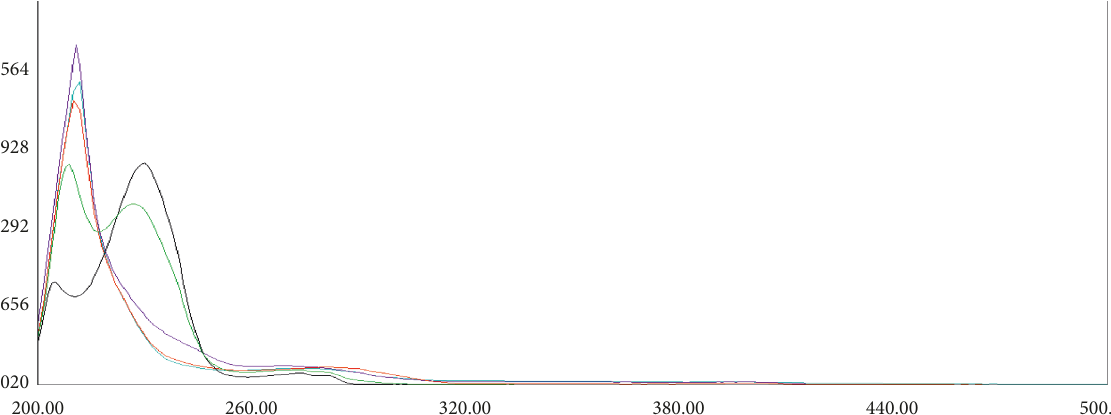
Figure 3: UV-Vis scan spectrum of total components from Aconitum extract in rats. (1) The blank plasma was illustrated by red line; (2) the drug plasma sample obtained at one hour after a single dose by purple; (3) the drug plasma sample obtained at one hour after a multiple dose by blue; (4) the reference substance aconitine in methanol solution by green; (5) the blank plasma spiked with aconitine by black. Table 1: The recoveries and precision for aconitine in rats plasma ( n 6). (cid:31)